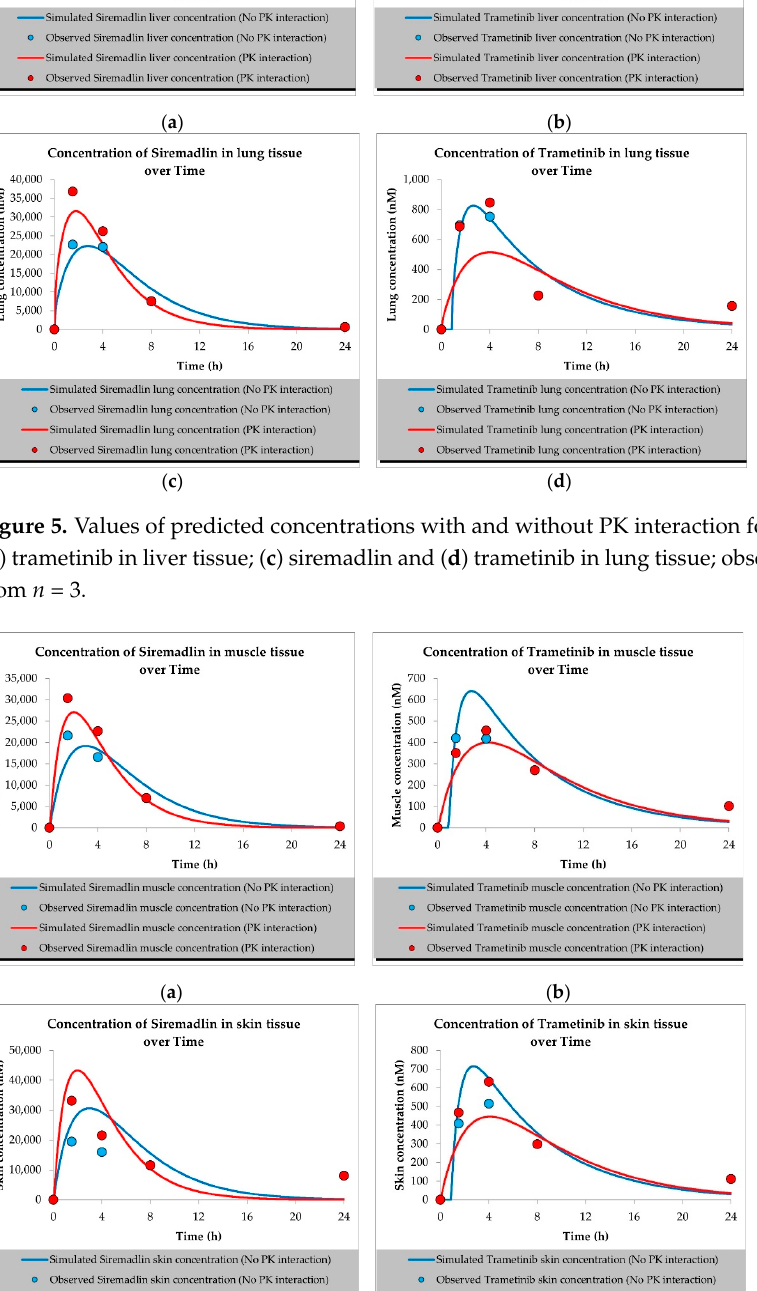
Figure 6. Values of predicted concentrations with and without PK interaction for ( a ) siremadlin and ( b ) trametinib in muscle tissue; ( c ) siremadlin and ( d ) trametinib in skin tissue; observed data are means from n = 3.